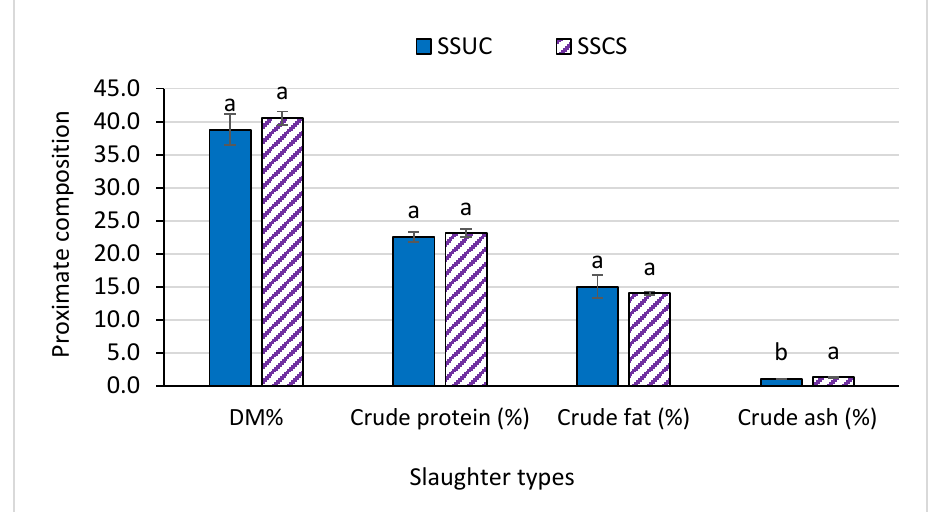
Figure 1. Effect of slaughtering with or without state of consciousness on Longissimus dorsi muscle’s proximate composition in Korean Hanwoo Finishing Cattle. a, b Means in the same bar with different superscript letters are significantly different at p < 0.05. Korean Hanwoo Finishing Cattle (KHFC) were slaughtered following two methods: (1) SSUC: slaughtering by applying captive bolt stunning, brain and spinal cord disruption, and neck cutting with unconscious state of animal and (2) SSCS: slaughtering by applying captive bolt stunning, without brain and spinal cord disruption and neck cutting with conscious state of animal.